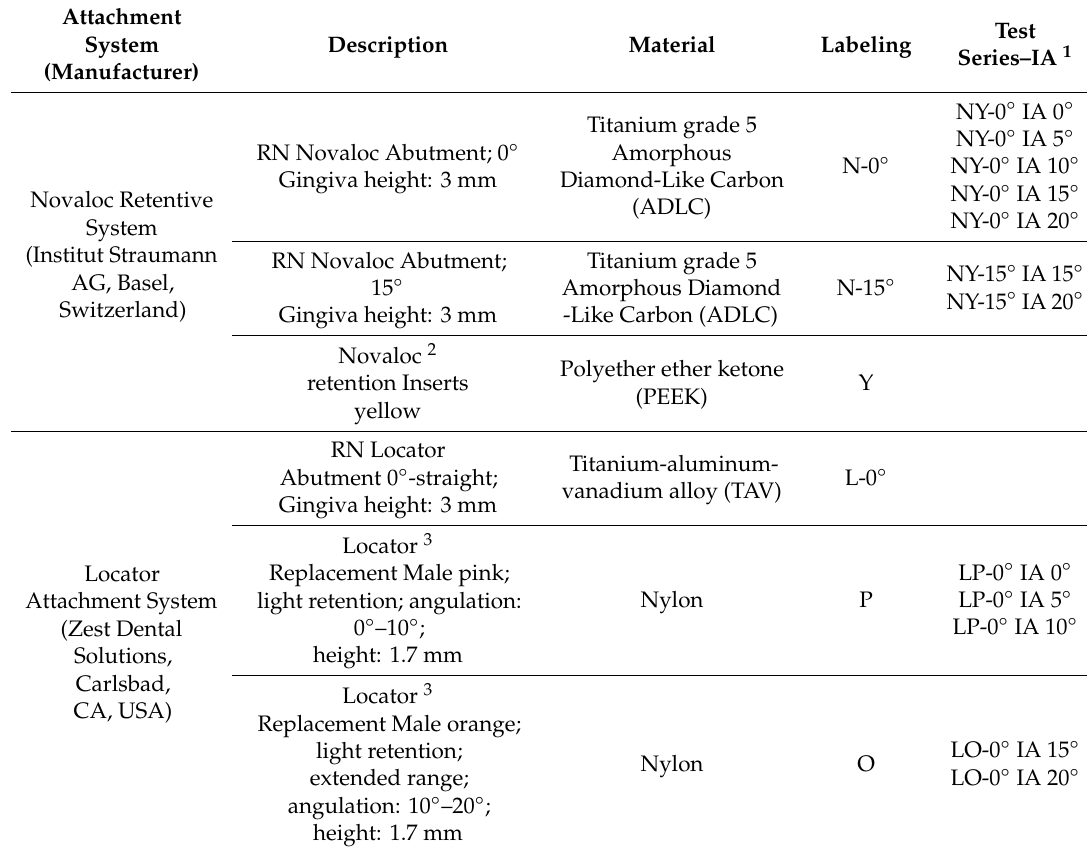
Table 1. Materials and labeling of test